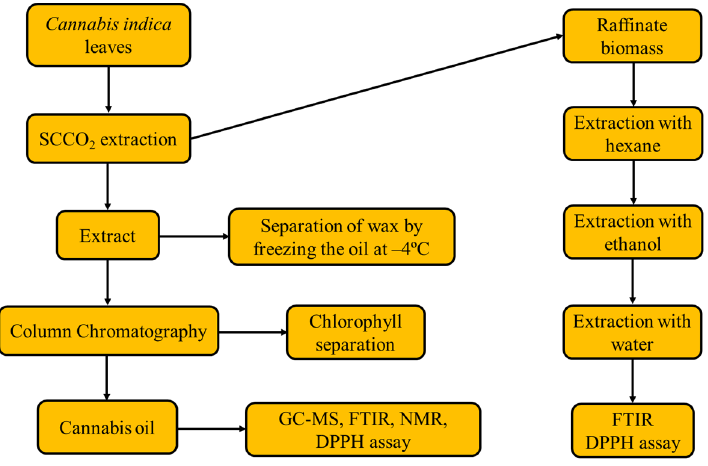
Figure 7. Process flow diagram of experiments and analyses in this study.